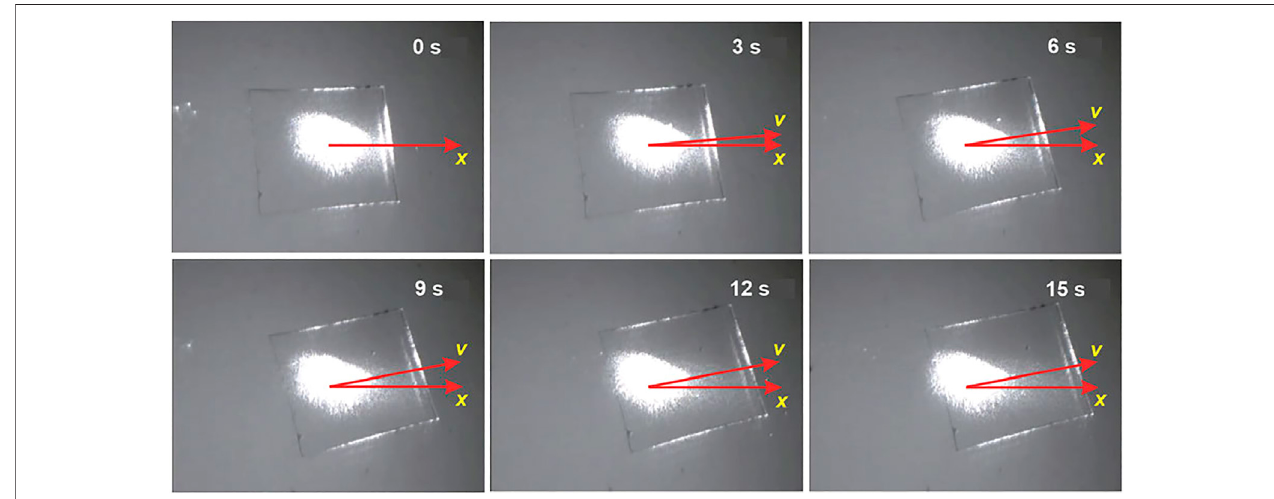
FIGURE9 | Rotation and rectilinear motion of plate 4 (see Figure 8 ) induced by a1 W-power incident laser beam impingingthe plate at an angle of58 ° . The bright spot is the “ trace ” of the incident beam impinging the plate.